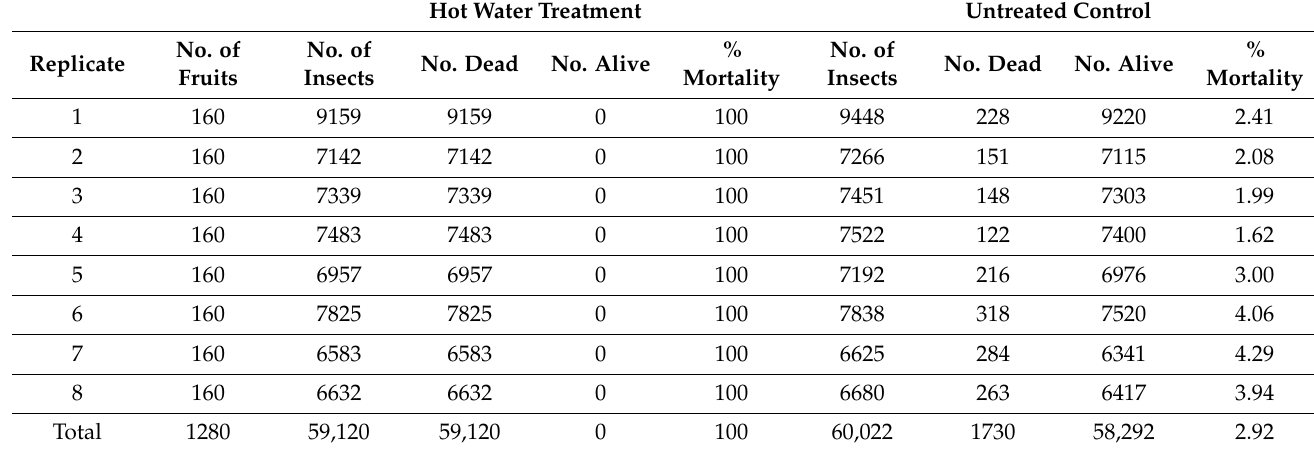
Table 4. Mortality of third-instar larvae of Bactrocera dorsalis in Tommy Atkins mango fruit subjected to hot water of 46.1 ◦ C for 72.63